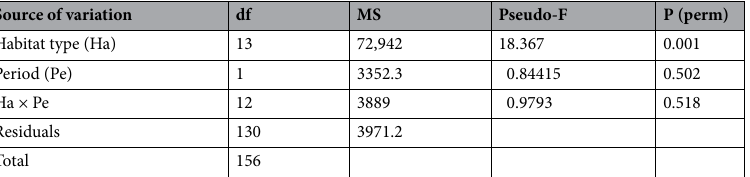
Table 3. PERMANOVA table of results: comparison of habitat descriptors assemblage per station between habitats and period. Table gives degrees of freedom (df), Mean Squares (MS), calculated pseudo-F, and P-values (P). P-values were obtained by 999 permutations of residuals under a reduced model (perm) or through Monte Carlo test (MC, see “Material and methods”).